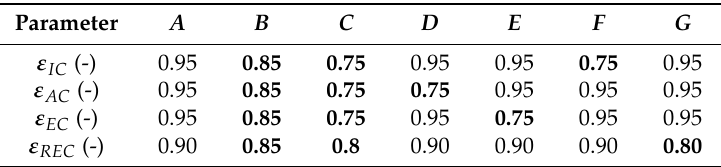
Table 3. Cycle nomenclature